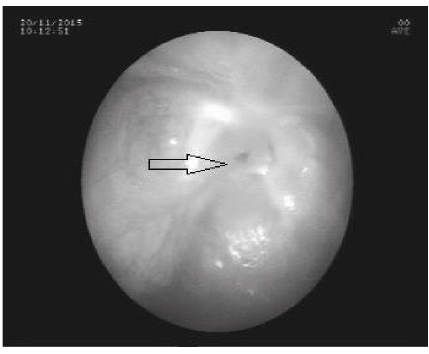
Figure 2: Almost a complete obstruction was revealed by endoscopy.